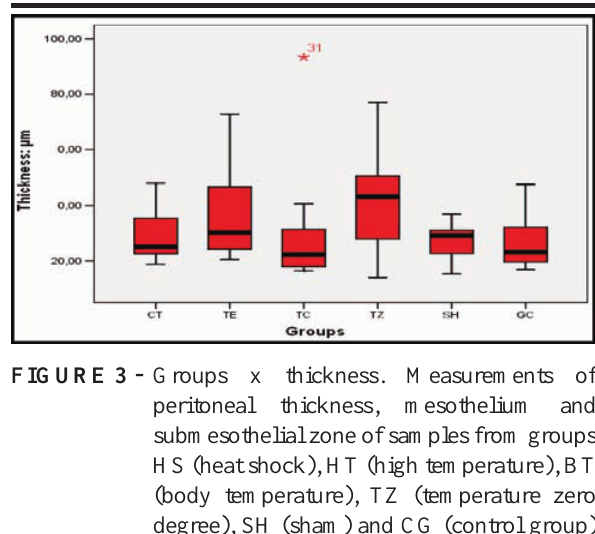
FIGURE 3 - Groups x thickness. Measurements